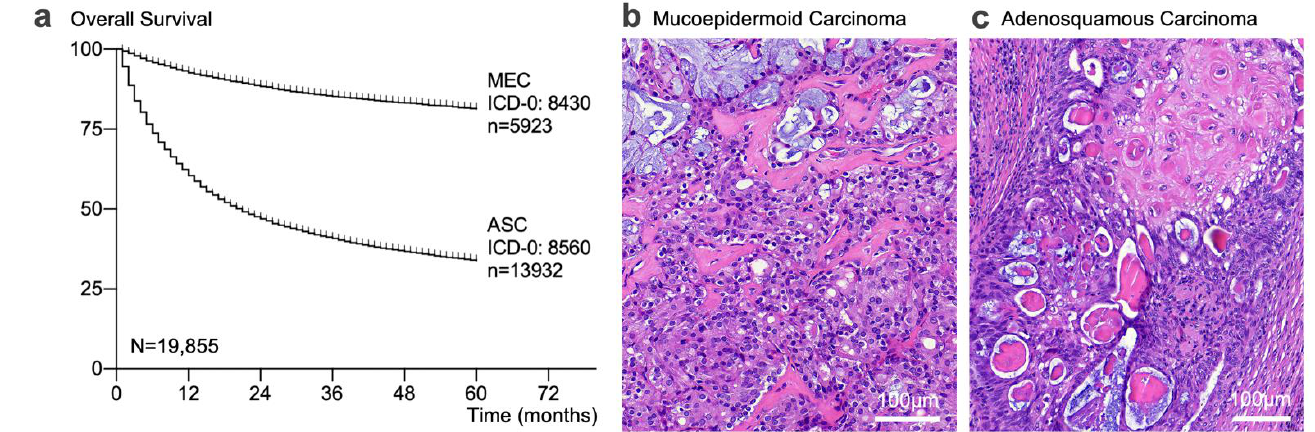
Figure 1. Survival Analysis and Morphology of Mucoepidermoid Carcinoma (MEC) and Adenosquamous Carcinoma (ASC). ( a ) Data were accessed using the SEER database comprised of 18 registries from 2000–2017 from the National Cancer Institute. Only patients with mucoepidermoid carcinoma (MEC, ICD-O-8430) and adenosquamous carcinoma (ASC, ICD-O-8560) were included in this analysis. Reports of observed survival were pulled as case listings and analyzed using the Kaplan–Meier method. ( b ) Mucoepidermoid carcinoma (MEC; MAML2+). ( c ) Adenosquamous carcinoma (ASC; MAML2–) with keratinizing and non-keratinizing squamous and glandular components. Abbreviations: ASC, adenosquamous carcinoma; MEC, mucoepidermoid carcinoma.